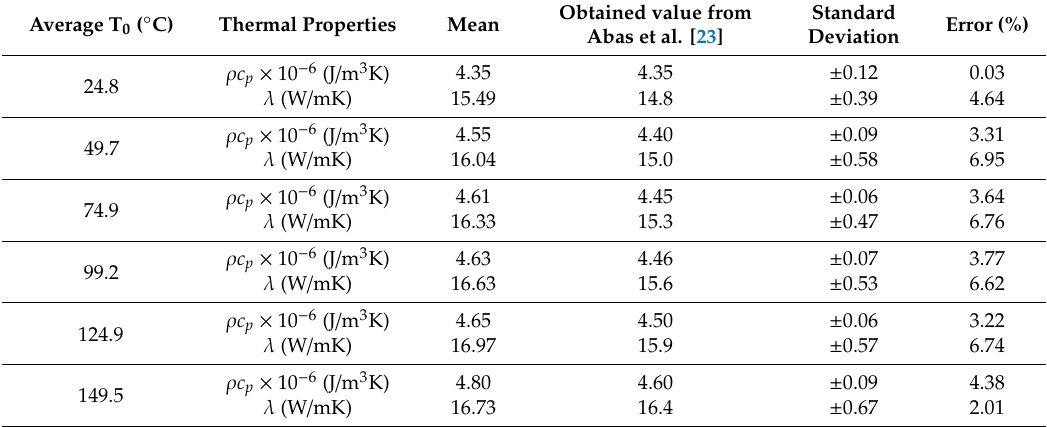
Table 2. Results obtained for the AISI 304 stainless steel sample.